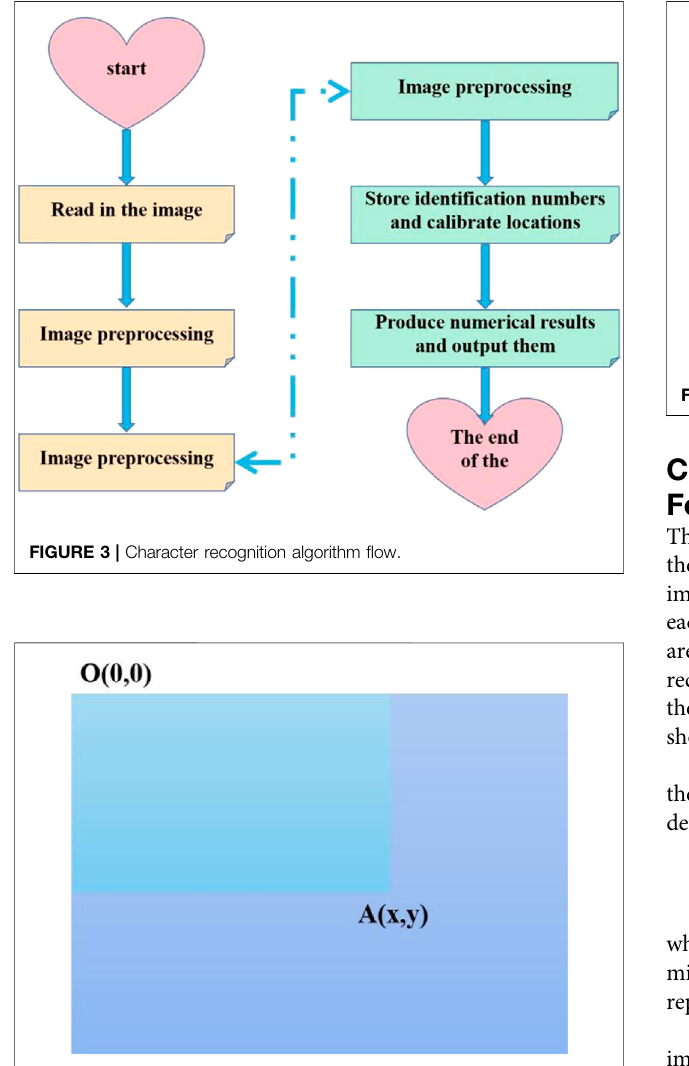
FIGURE 4 | Integral diagram representation method.